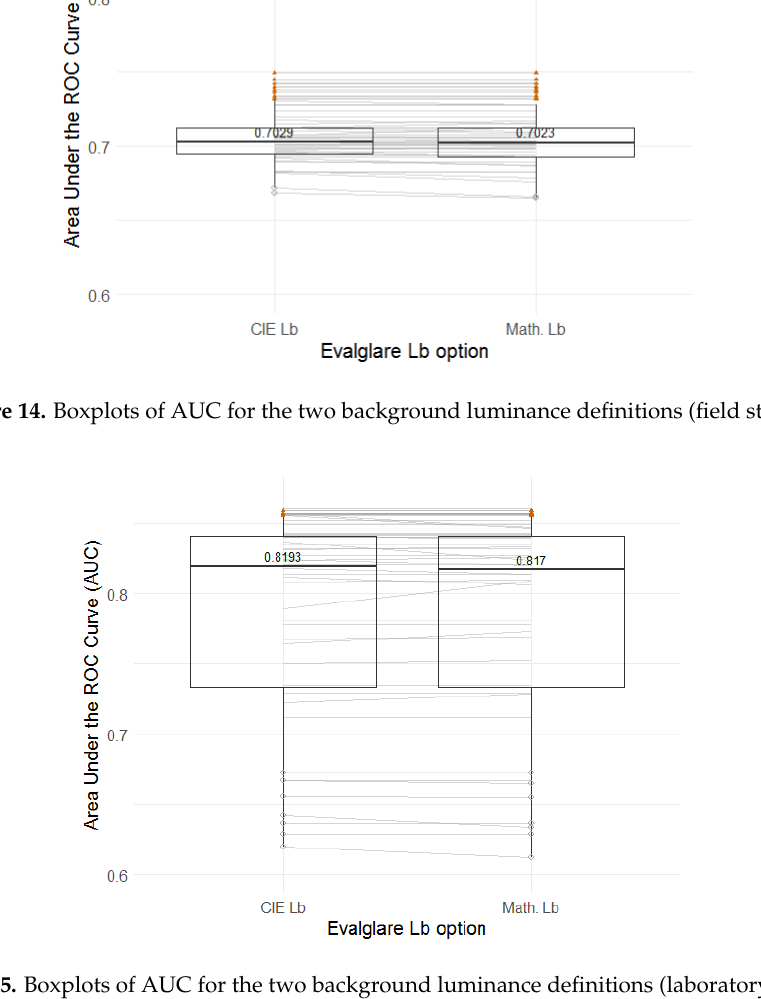
Figure 15. Boxplots of AUC for the two background luminance definitions (laboratory study).